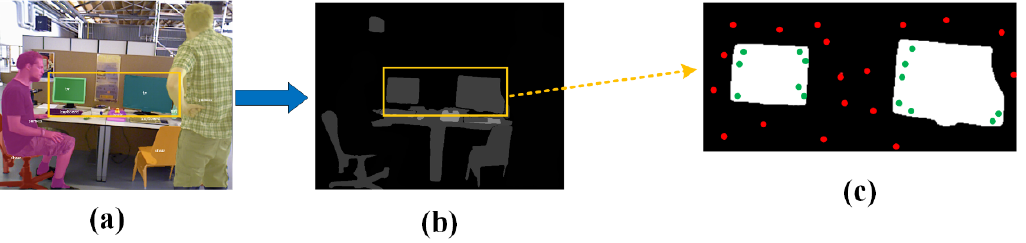
Figure 10. Semantic constraint principle. ( a ) shows the result of the Instance segmentation. ( b ) shows the result after being converted into a grayscale image. ( c ) is a schematic diagram of projection points.